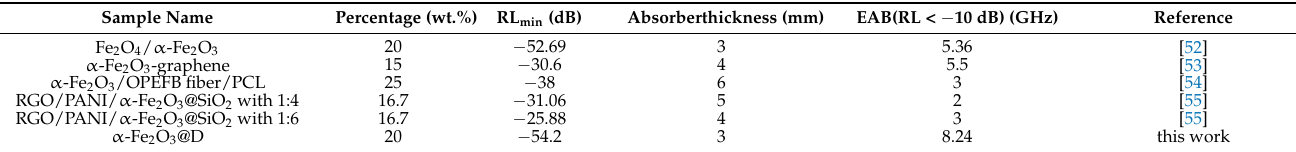
Table 2. Comparison with other De basic